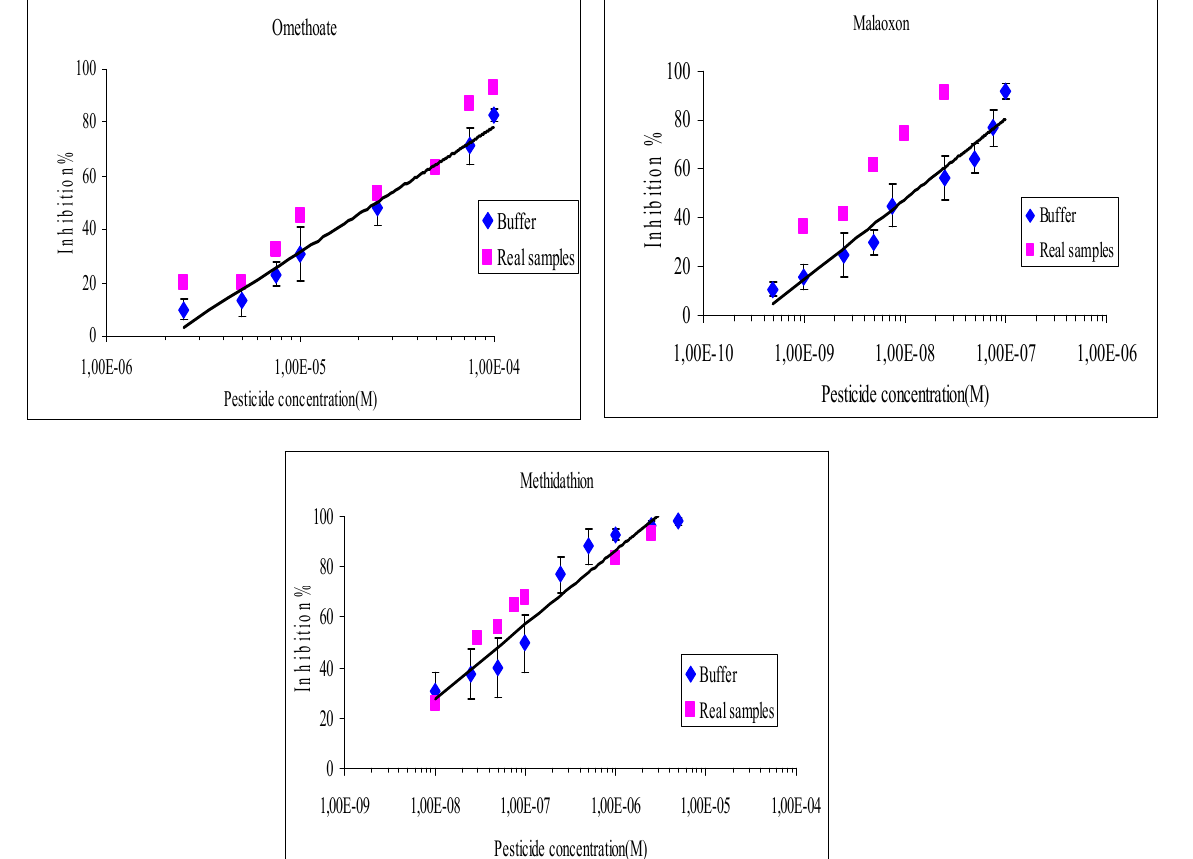
Figure 4. Comparison of inhibition effects of omethoate, methidathion and malaoxon in olive oil real samples and buffer, detection by optical method.